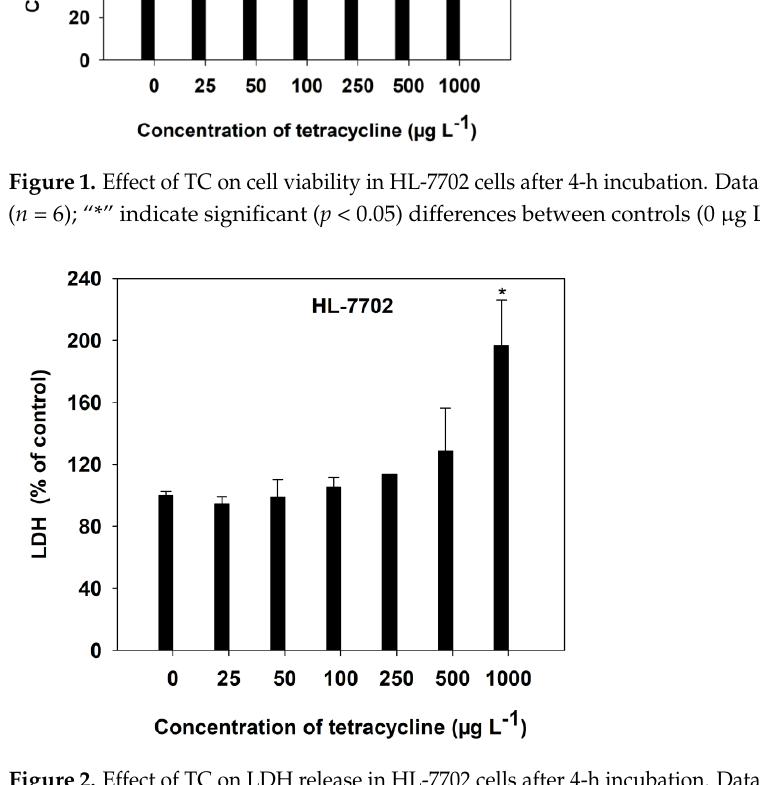
Table 1. Regression equations between cell viability; activities of lactate dehydrogenase (LDH), al- anine transaminase (ALT), aspartate transaminase (AST), alkaline phosphatase (ALP) and catalase (CAT); contents of hydrogen peroxide (H 2 O 2 ) and malondialdehyde (MDA); the concentrations of added tetracycline (TC) in the normal human liver cell line HL-7702. MDA